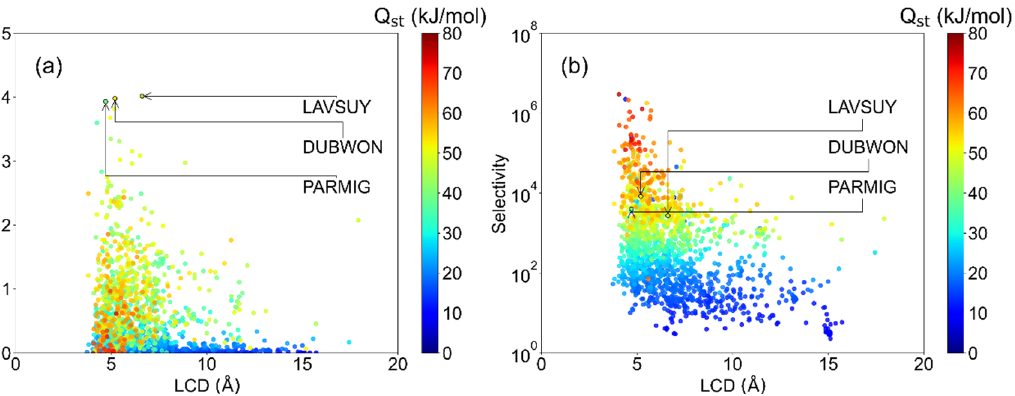
Figure 1. Relationship between the largest cavity diameter (LCD) and ( a ) HCHO working capacity, ( b ) selectivity, colored by the heat of adsorption (Q st ). ( b ) selectivity, colored by the heat of adsorption (Q st